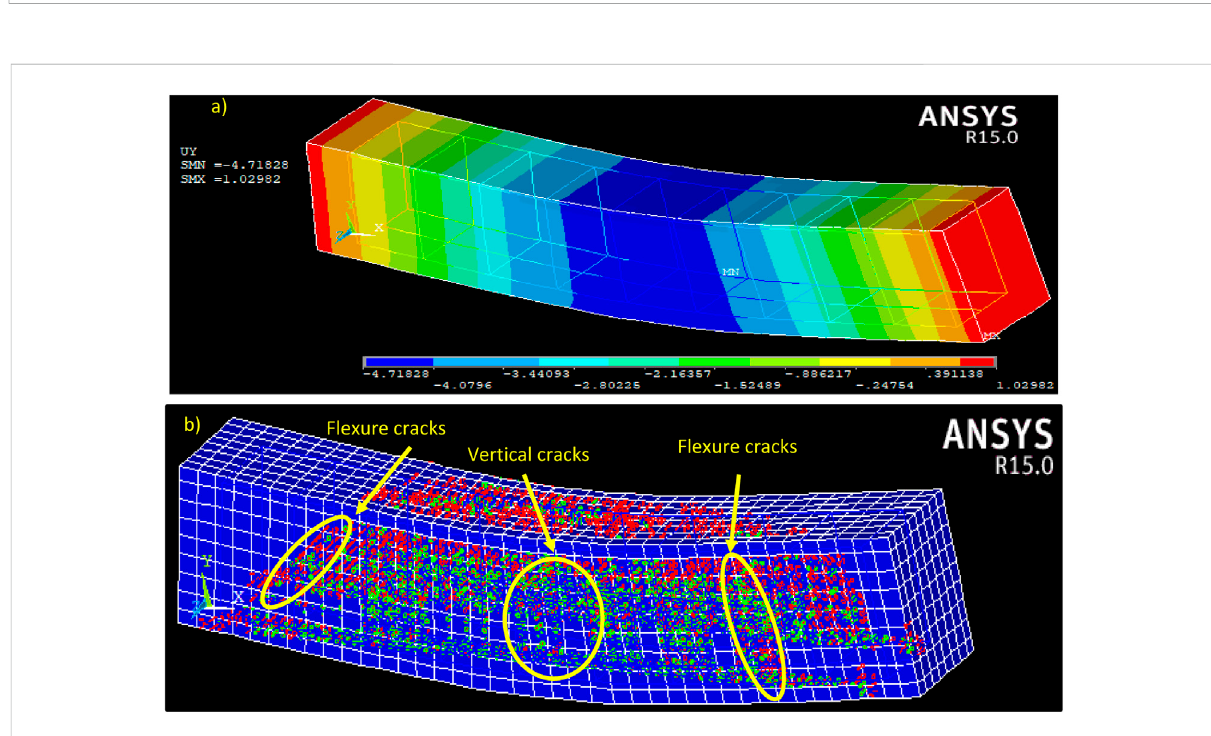
FIGURE 17 The 3D fi nite element analysis on concrete with 100% bottom ash shows results that may be seen on (A) contour plots, and (B) a view of the fractures in the